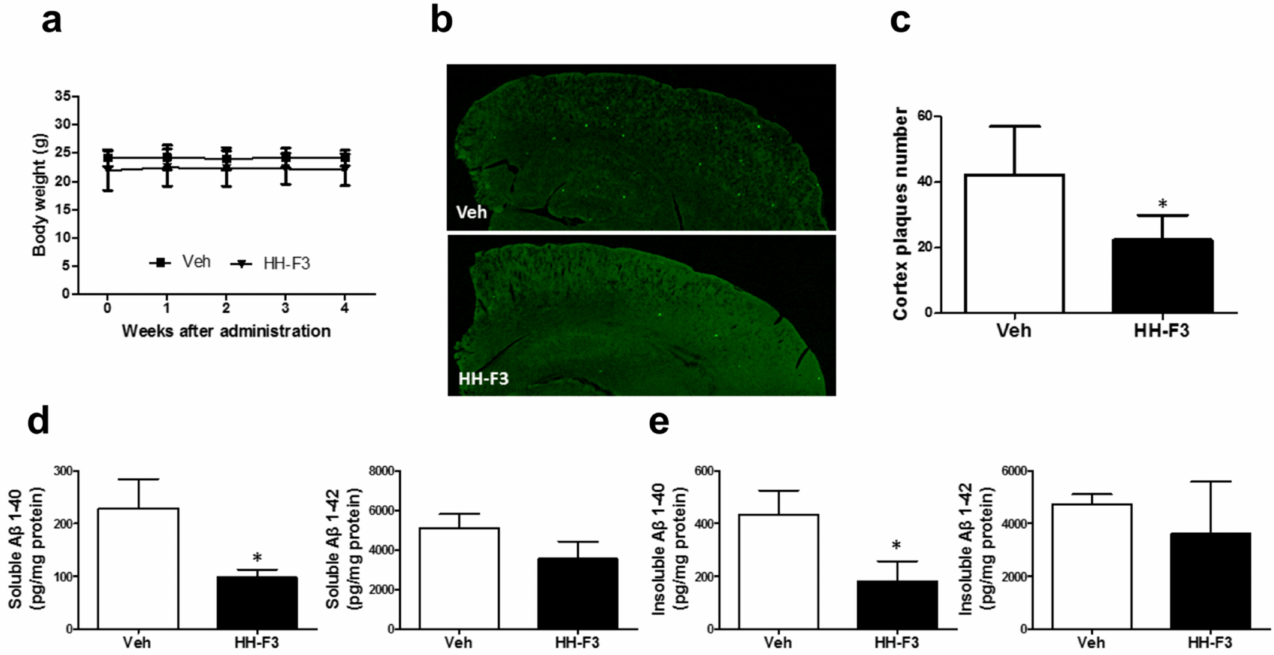
Figure 2. GP extract HH-F3 diminished amyloid plaque formation and A β levels in the cerebral cortex of APP/PS mice. HH-F3 at 0 or 300mgkg − 1 per day was given to 5-month-old APP/PS1 for 30 days. ( a ) The body weights of APP/PS1 mice fed with or without HH-F3. ( b ) ThS-stained A β plaques in the cerebral cortex region of APP/PS1 mice fed with or without HH-F3. ( c ) The number of relative total areas in the cerebral cortex region. ( d ) Levels of A β 40 and A β 42 in the soluble fraction from the brain homogenates of APP/PS1 mice treated with or without HH-F3. ( e ) Levels of A β 40 and A β 42 in the insoluble fraction from the brain homogenates of APP/PS1 mice treated with or without HH-F3. Data were analyzed by Student’s t -test. Levels of significance are shown as * p <